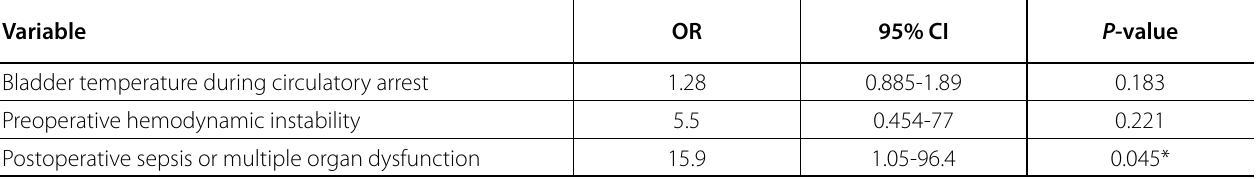
Table 6 . Multivariable logistic regression analysis for the main determinants of the incidence of postoperative severe neurological outcome